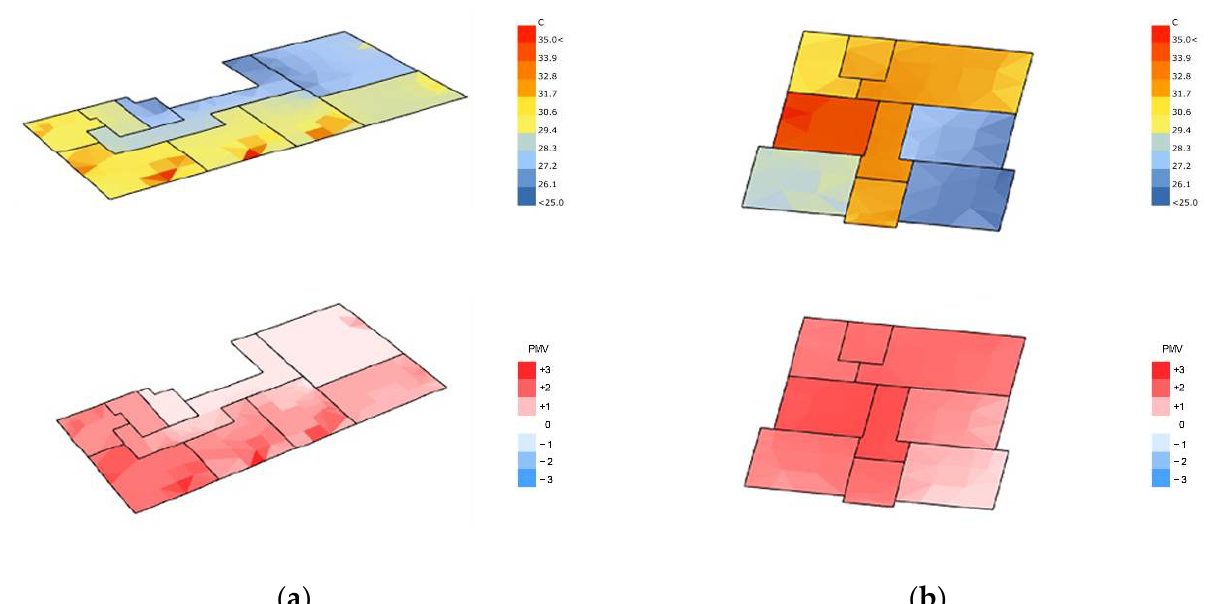
Figure 12. The actual indoor output of air temperatures and PMV: ( a ) The simulated flat for the Materdei building; ( b ) The simulated flat for the Ponticelli building. A comparison between the indoor PMV average values recorded by the questionnaire and the simulated ones is shown in Table